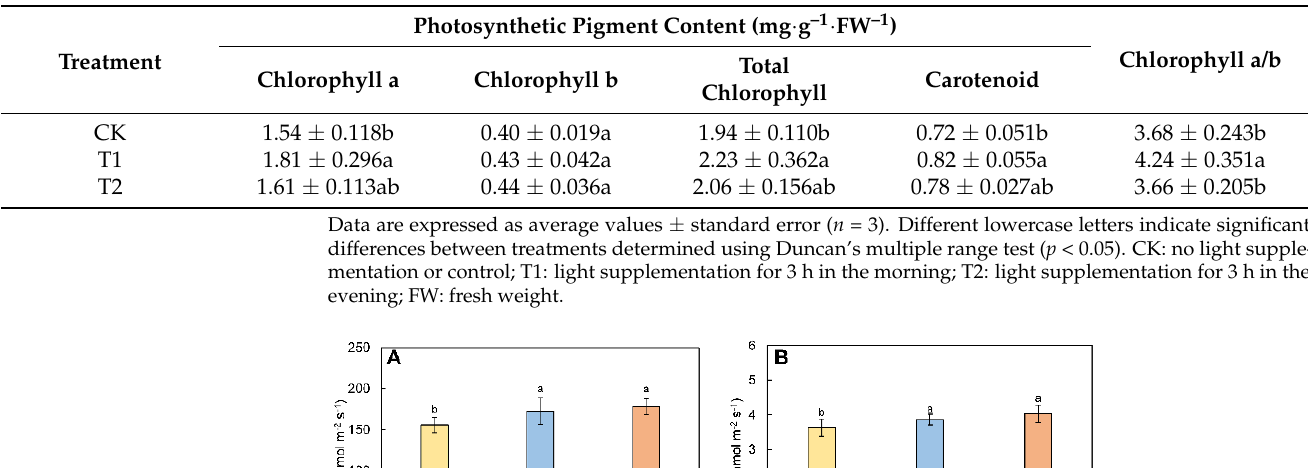
Table 1. Photosynthetic pigment content in tomato leaves of plants exposed to different LED light supplementation durations.